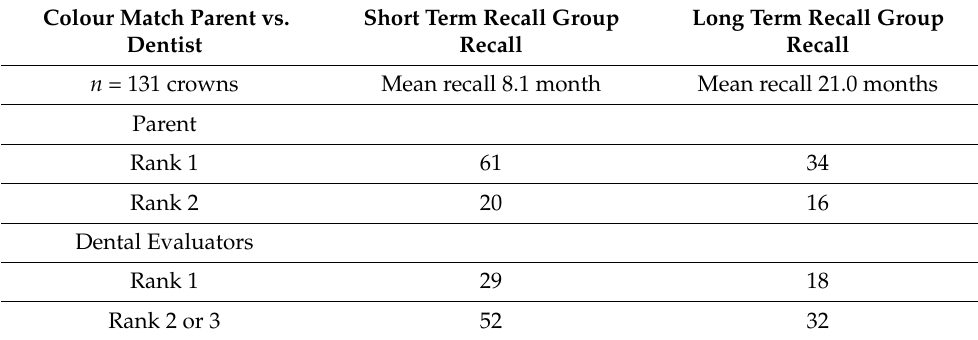
Table 5. Colour match ranking by parent or dental evaluator for short-term and long-term follow-up. Colour Match Parent